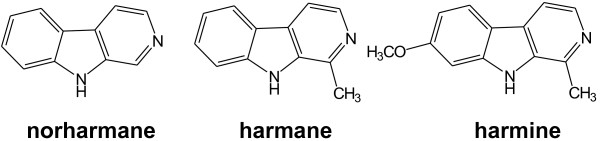
Structure of the different βCs studied: harmane, norharmane and harmine.